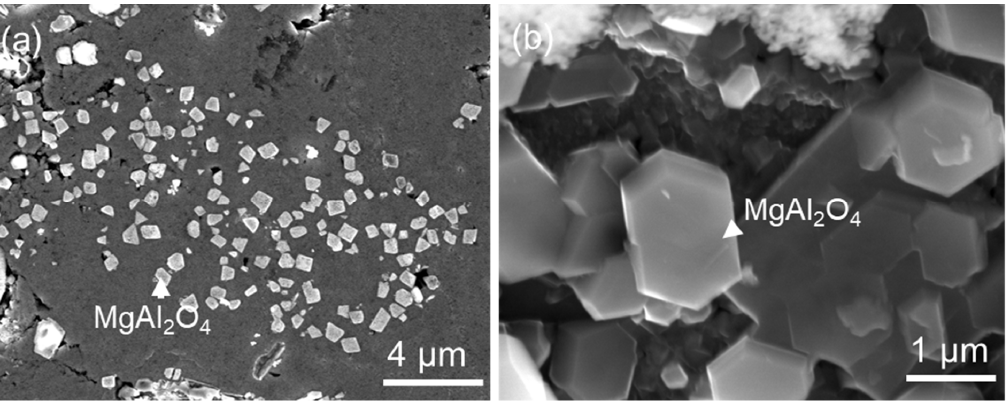
Figure 15. SEM (in lens) image showing ( a ) the 2-dimension and ( b ) 3-dimension the native MgAl 2 O 4 par-ticles in prefilled Al-3Fe-1Mg.